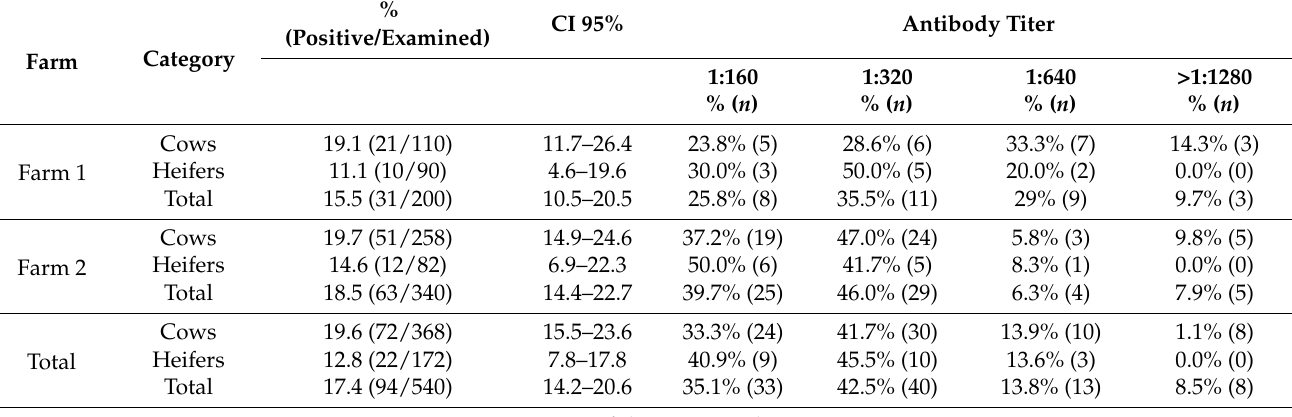
Table 1. Serological prevalence of Neospora caninum infection in cattle from two farms in northern Italy according to both immunofluorescence antibody test and productive categories of cattle. Antibody titers are also reported.